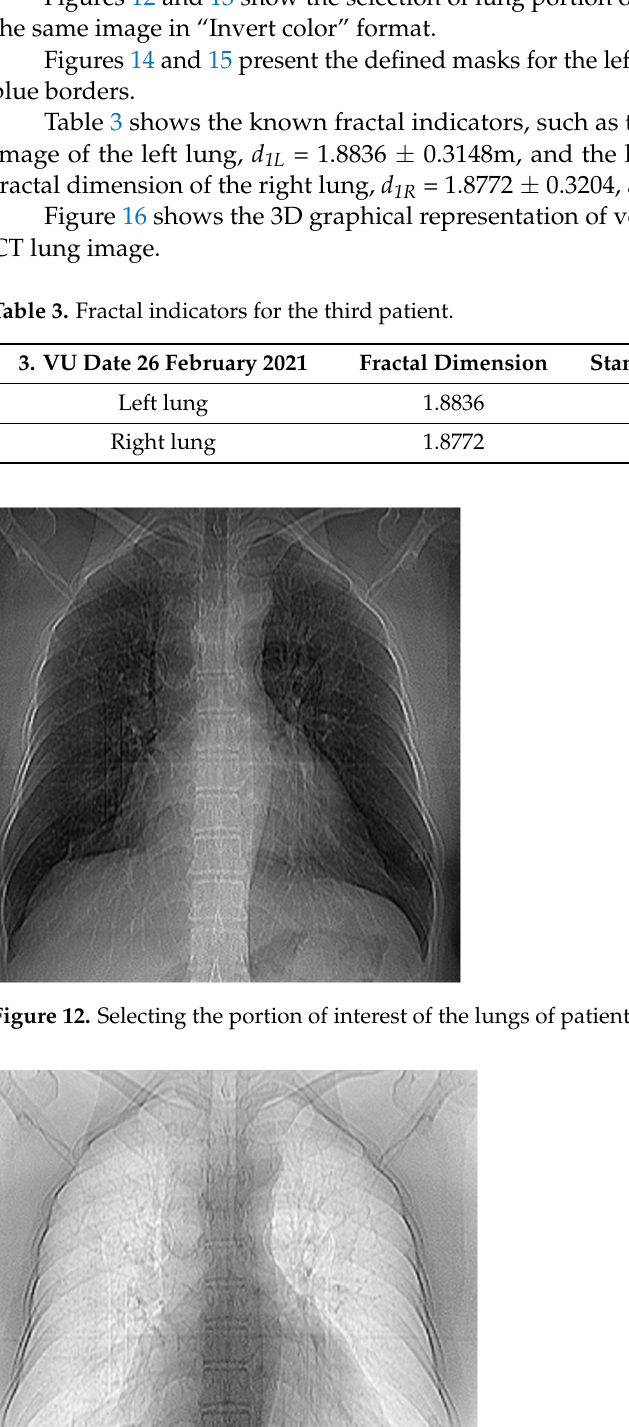
Figure 14. De fi ning the mask for the left lung of the third patient. Figure 15. De fi ning the mask for the right lung of the third patient.